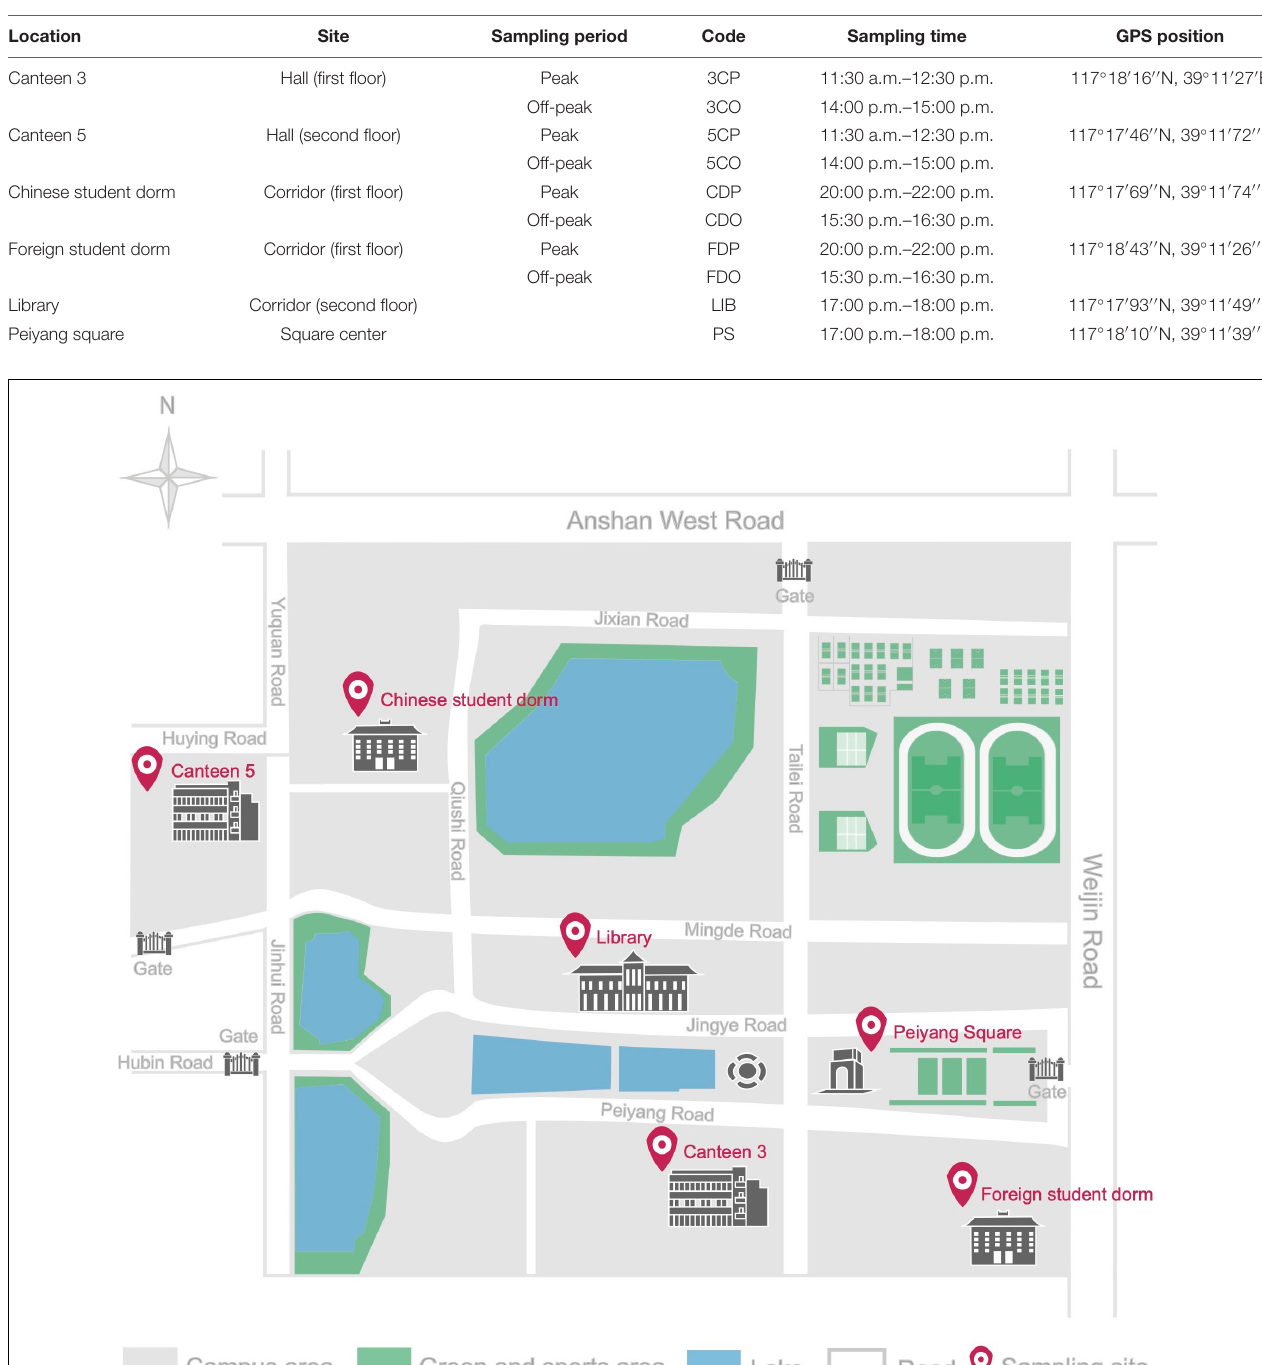
TABLE 1 | Characteristics of the six sampling sites.